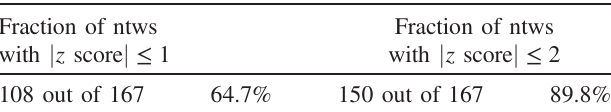
TABLE IV. Fraction of networks whose discrepancy between the real and randomized nestedness is less than or equal to 1 σ or 2 σ for NODF distributions estimated on a sampling of the ensemble.